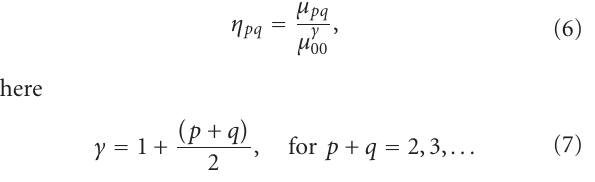
Figure 5: Thermal images of MFS.